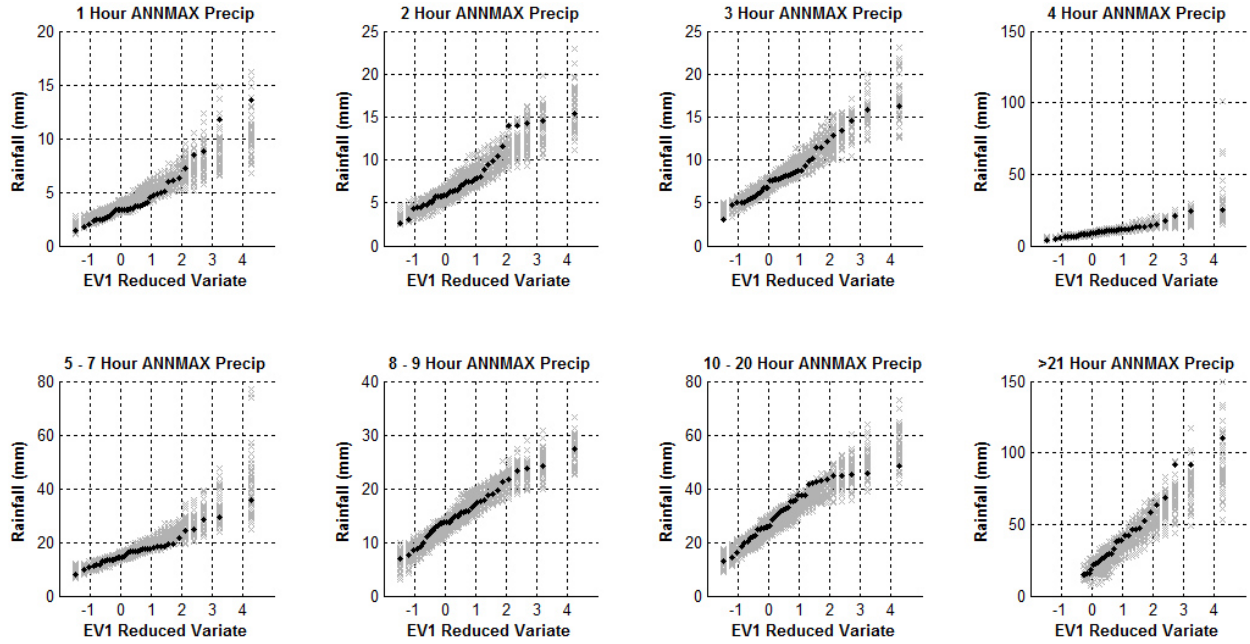
Figure 2. Modelled annual maximum rainfall totals for each duration class compared to the observational record for the Dodder catchment. The annual maxima for each class in the 40year catchment-average observed record are ranked and plotted using Gringorten plotting positions (black circles). The process was repeated for 50 × 40year simulated series (grey